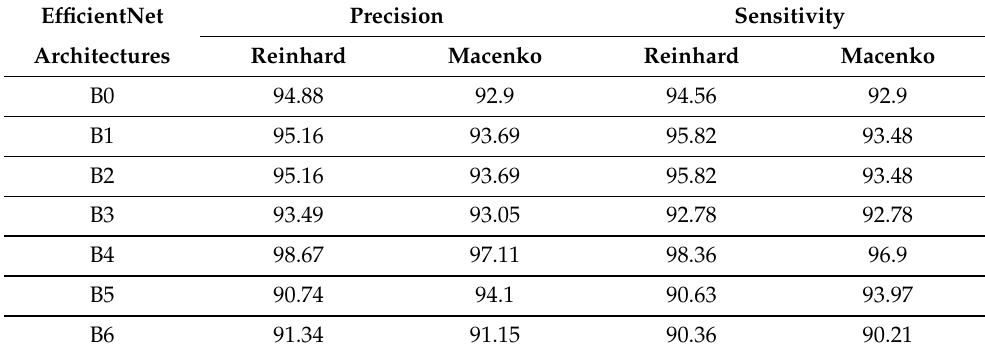
Table 5. Precision sensitivity for the EfficientNet models with the stain-normalization method. EfficientNet Precision Sensitivity Architectures